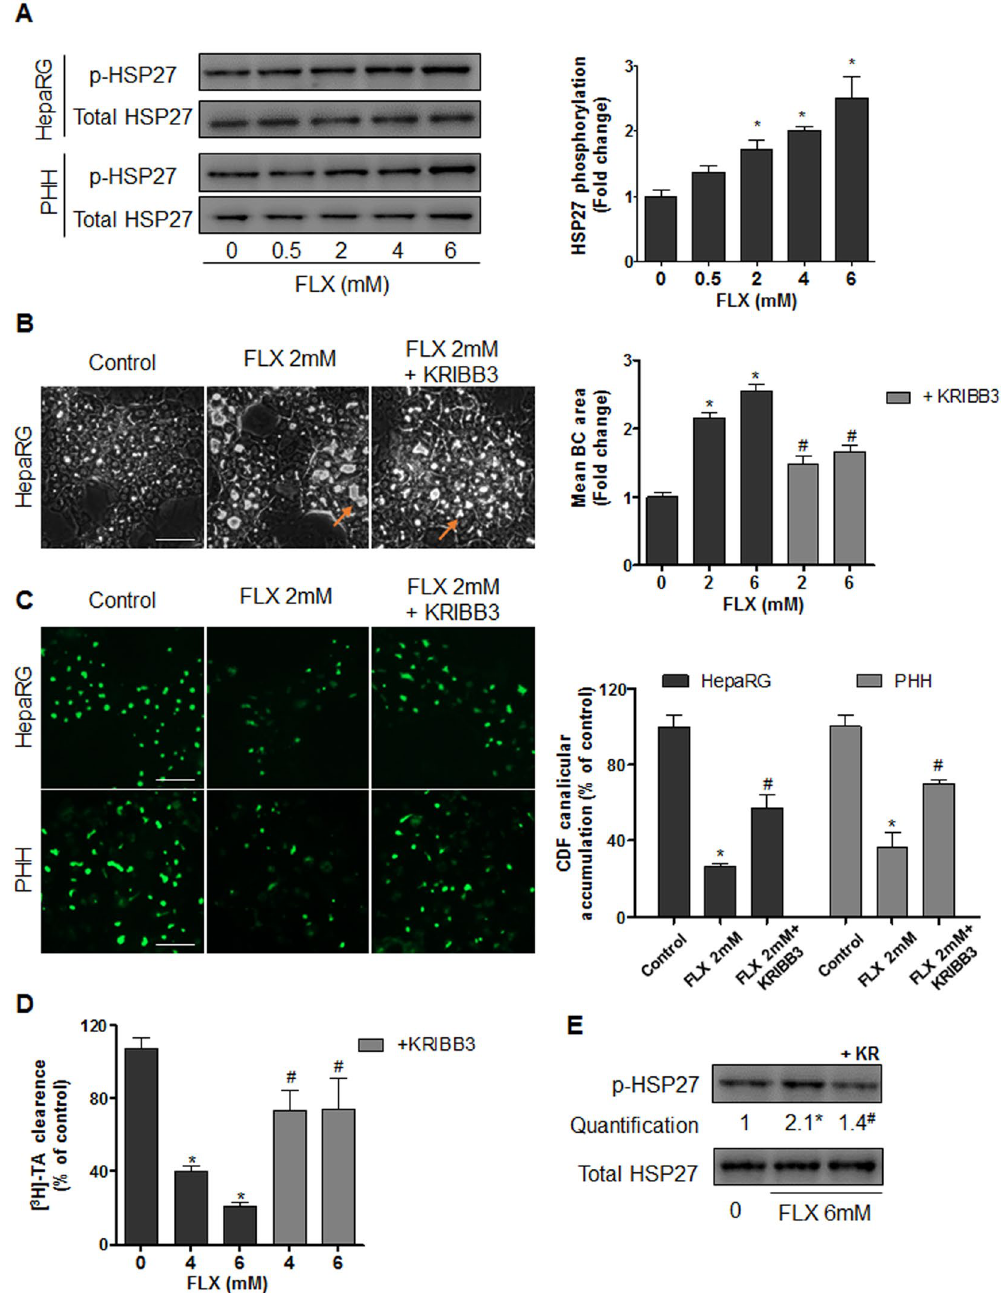
Figure 4. Involvement of HSP27 in FLX-induced effects. ( A ) Representative western blots of the p-HSP27/ total HSP27 forms after 2h-treatment with FLX (0–6 mM) in HepaRG cells and PHH. Quantification of HSP27 phosphorylation in HepaRG cells using ImageJ 1.48 software. The displayed blots were cropped and the original full-length gels are included in the supplementary information. ( B ) Representative phase-contrast images of HepaRG cells treated with 2 mM FLX alone or combined with 0.5 µ M KRIBB3 after 2 h. Quantification of BC area using ImageJ 1.48 software. Orange arrows indicate BC (bar = 50 μ m). ( C ) CDF efflux in HepaRG hepatocytes and PHH treated with 2 mM FLX alone or combined with 0.5 µ M KRIBB3 compared to untreated cells. Quantification of CDF accumulation in BC of HepaRG hepatocytes and PHH after 2 h treatment with 2 mM FLX ± 0.5 µ M KRIBB3 using ImageJ 1.48 software. ( D ) [ 3 H]-TA clearance in HepaRG cells treated with 4 or 6 mM FLX alone or co-treated with 0.5 µ M KRIBB3 for 2 h. ( E ) Representative western blots of p-HSP27/total HSP27 forms after 2 h-treatment with 6 mM FLX ± 0.5 µ M KRIBB3 (KR). Data were expressed relative to those of untreated cells arbitrarily set at 1 or 100%. They represent the means ± SEM of 3 independent experiments. * p < 0.05 compared with that of untreated cells, # p < 0.05 compared with that of cultures treated with FLX